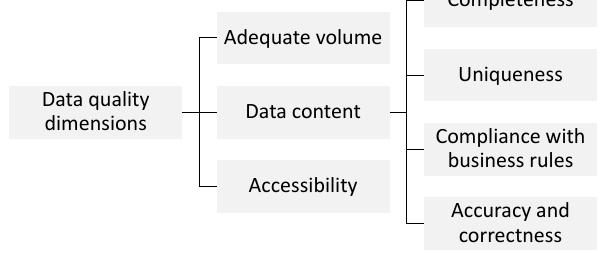
Figure 9. Cost–benefit analysis.